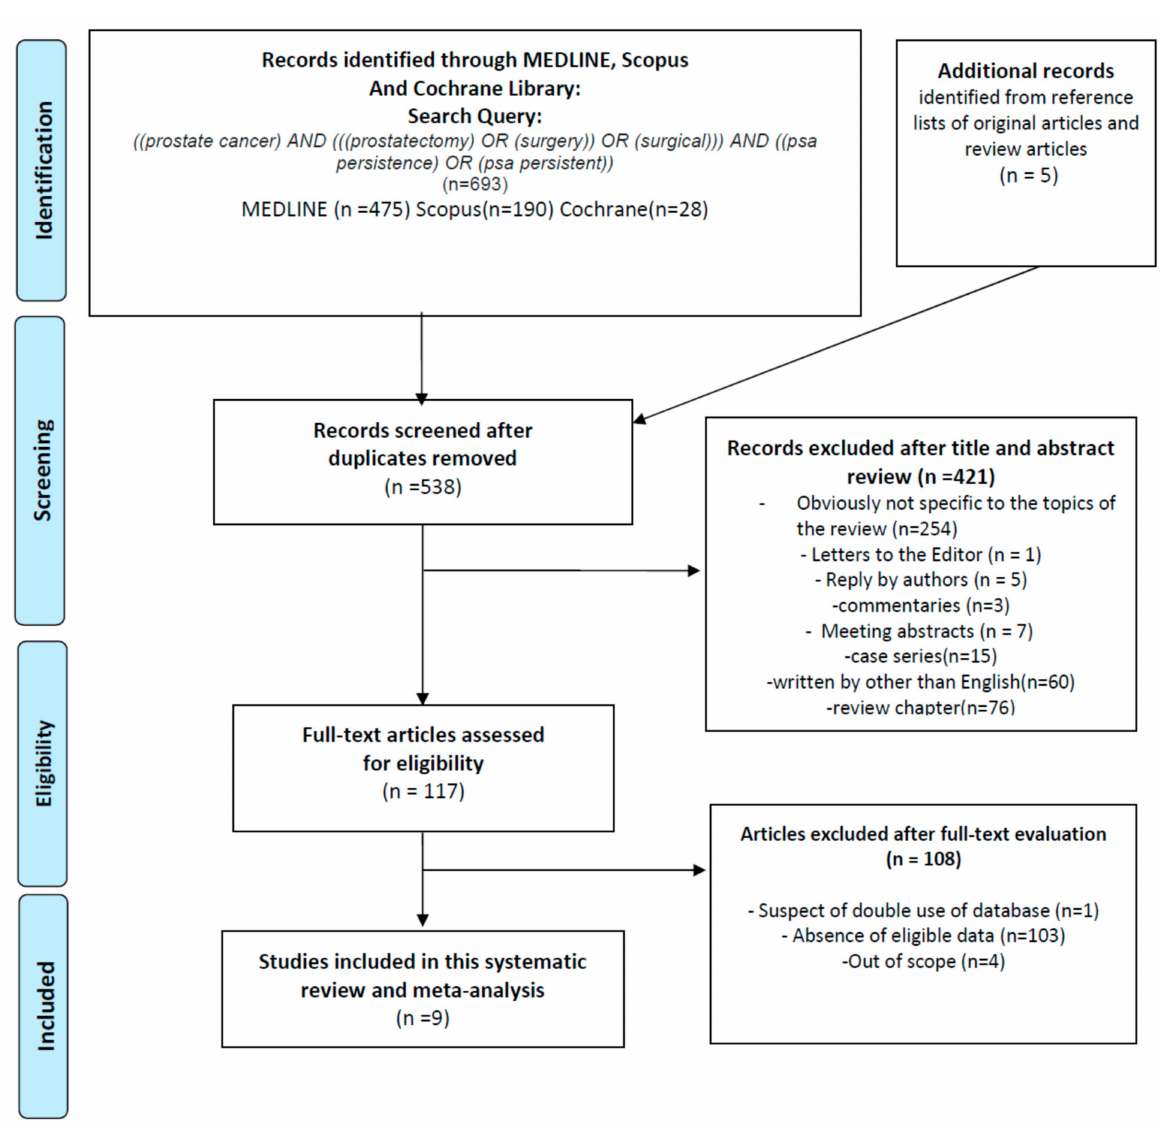
Figure 1. Flow chart for article selection process to analyze the prognostic significance of PSA persistence after radical prostatectomy in patients with prostate